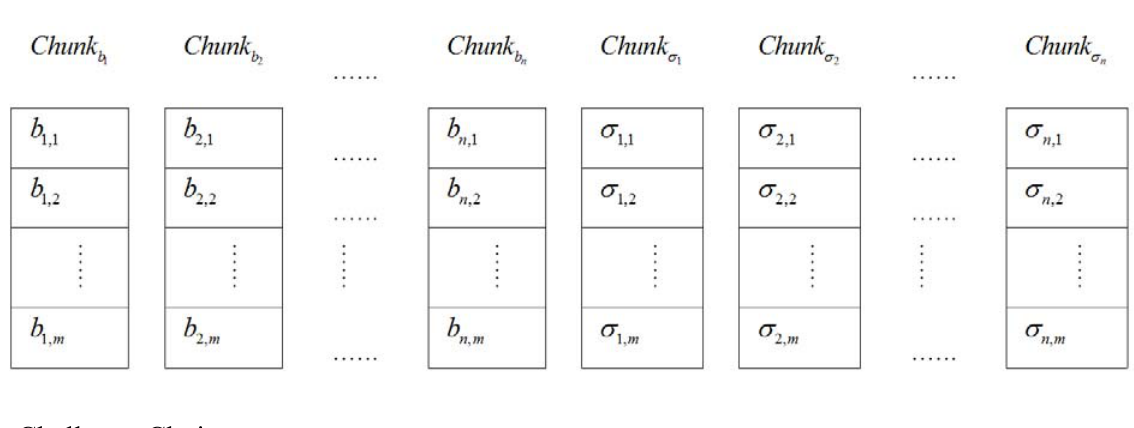
Figure 3. The storage distribution of evidence blocks and tags on the Chunk